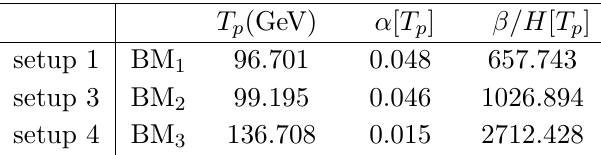
Table 2 . Three benchmark points for the illustration of GW production from a SFOEWPT for the setup 1, 3, and 4. Setup 2 is missing in this table due to the decoupling.